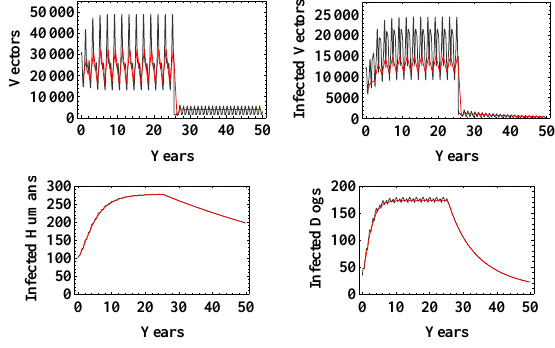
Fig. 1. System behavior in the baseline case without